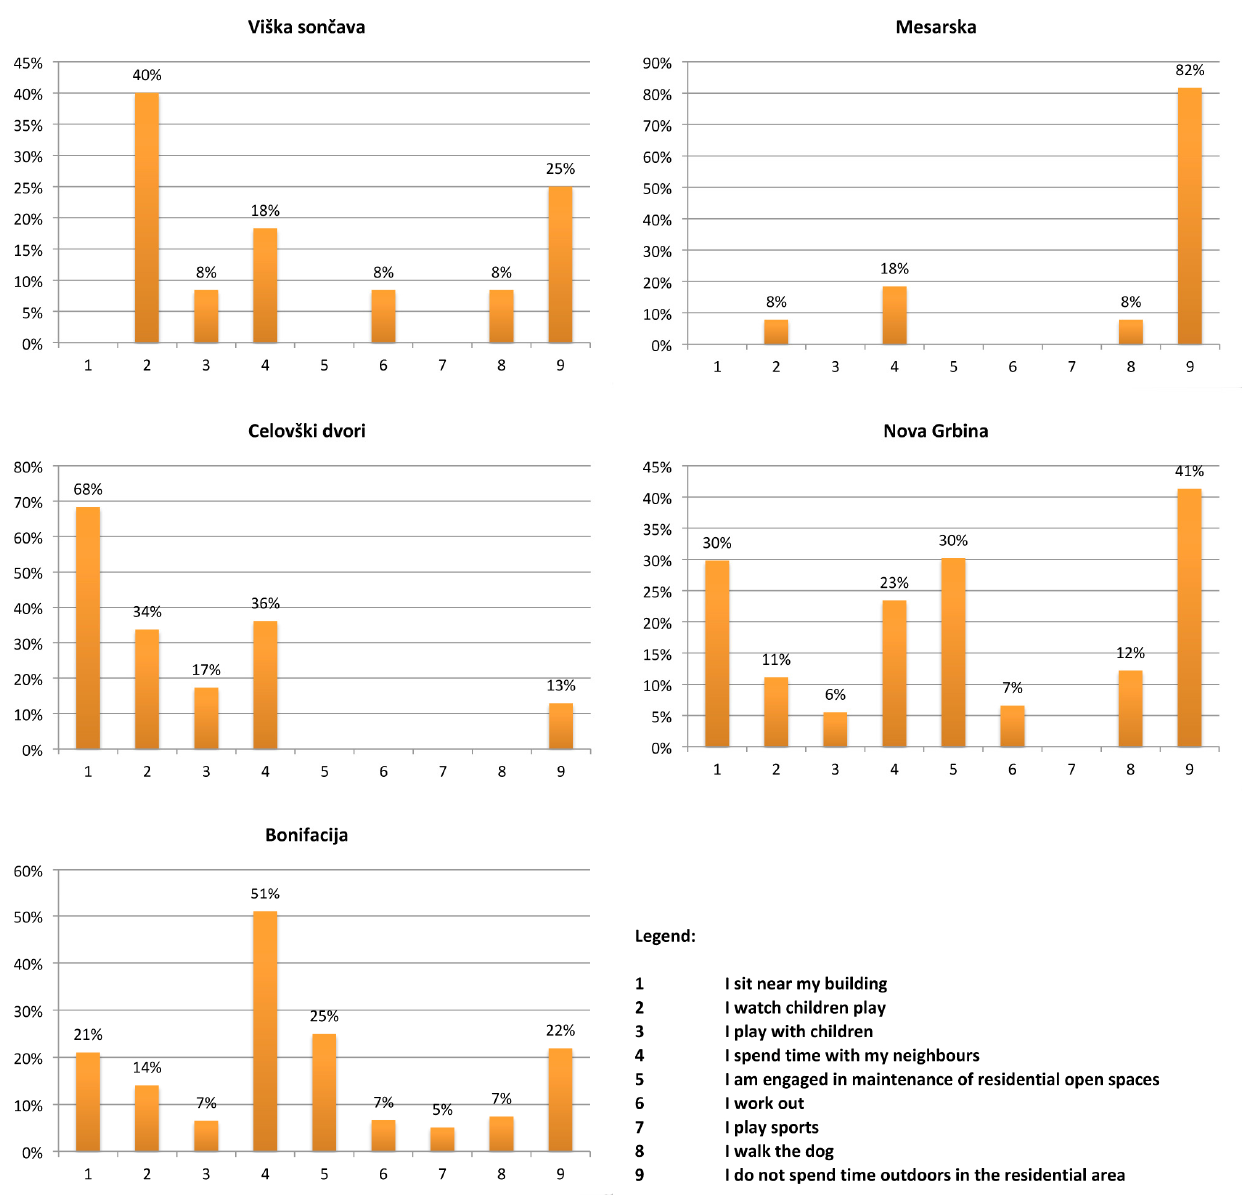
Figure 6. Answers to the question: “What do you normally do when you spend time in open spaces of your residential area?” by retired